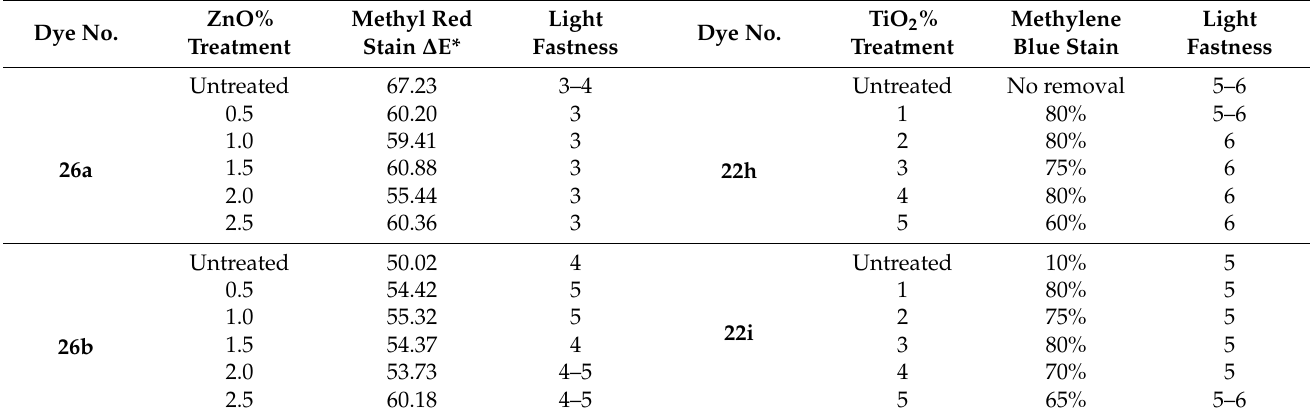
Table 7. Effect of Light fastness and Stains * on ZnO or TiO 2 NPs treated polyester fabrics. Dye